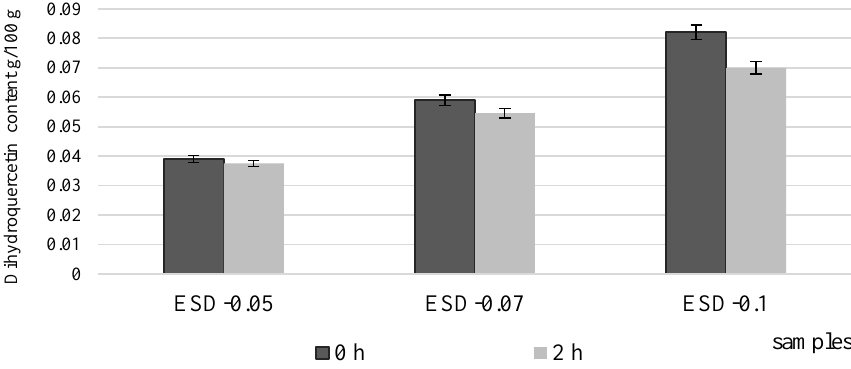
Figure 3. Dihydroquercetin content in dough samples.